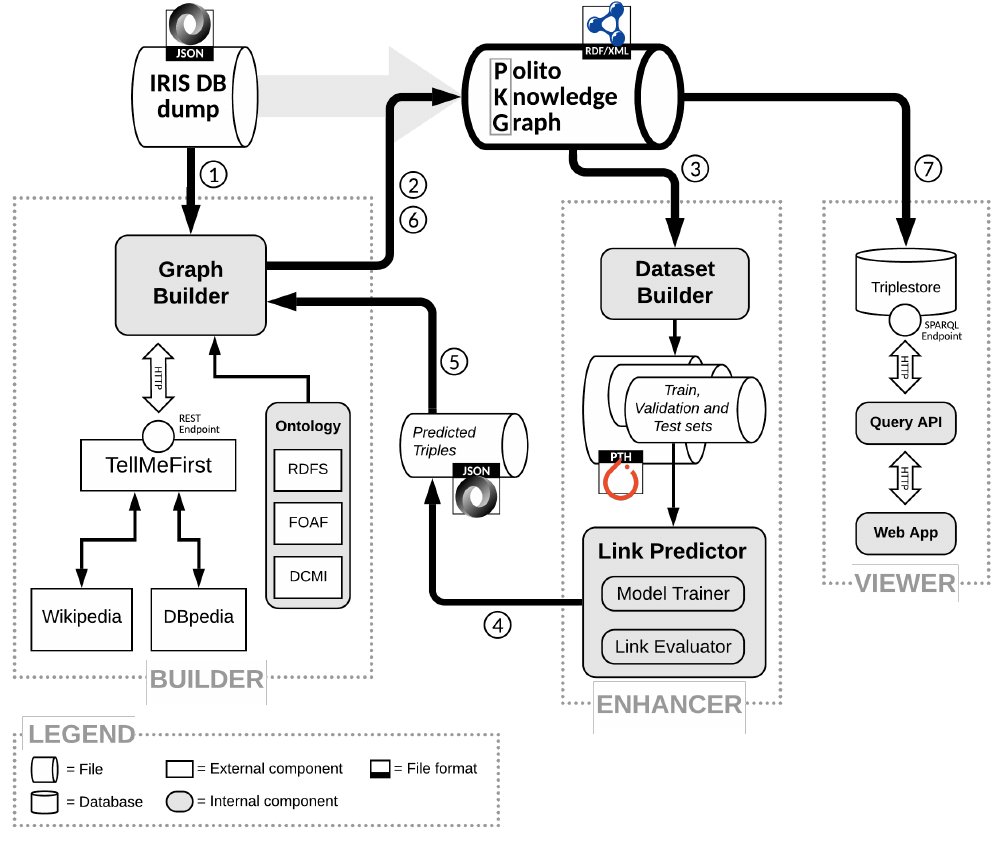
Figure 2. The pipeline of the Geranium